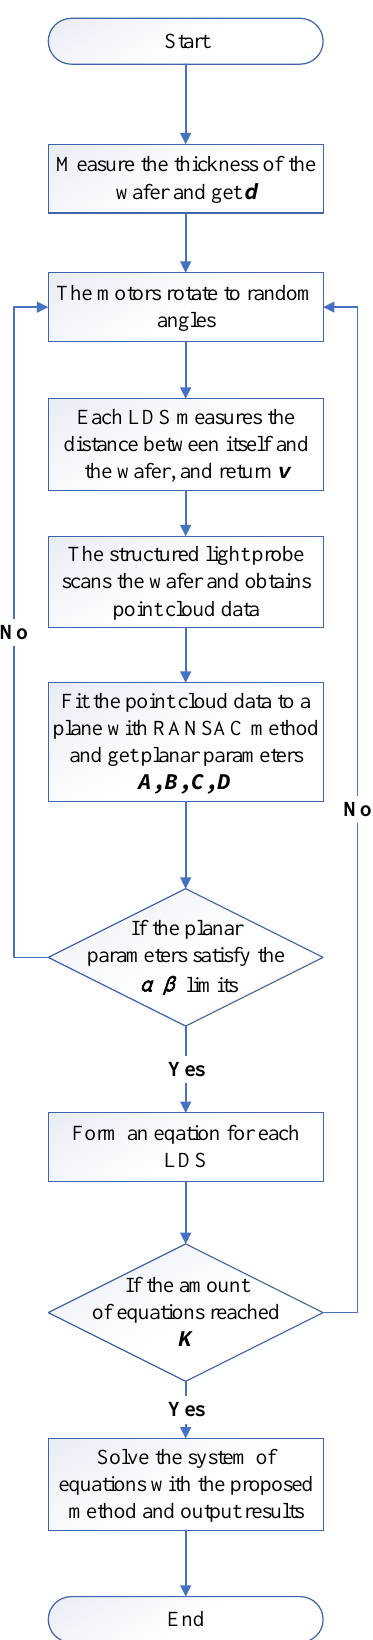
Figure 16. The calibration procedure of the